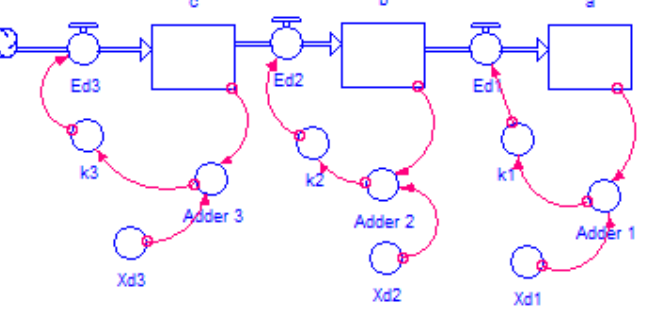
Figure 14. Forrester diagram for the ironing process with three state variables.